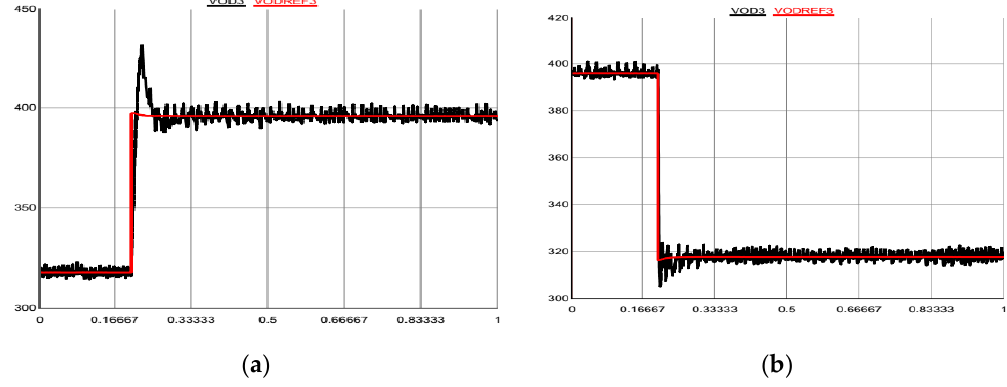
Figure 14. ( a ) DG3 output voltage and ( b ) DG3 reference voltage due to voltage step changes.